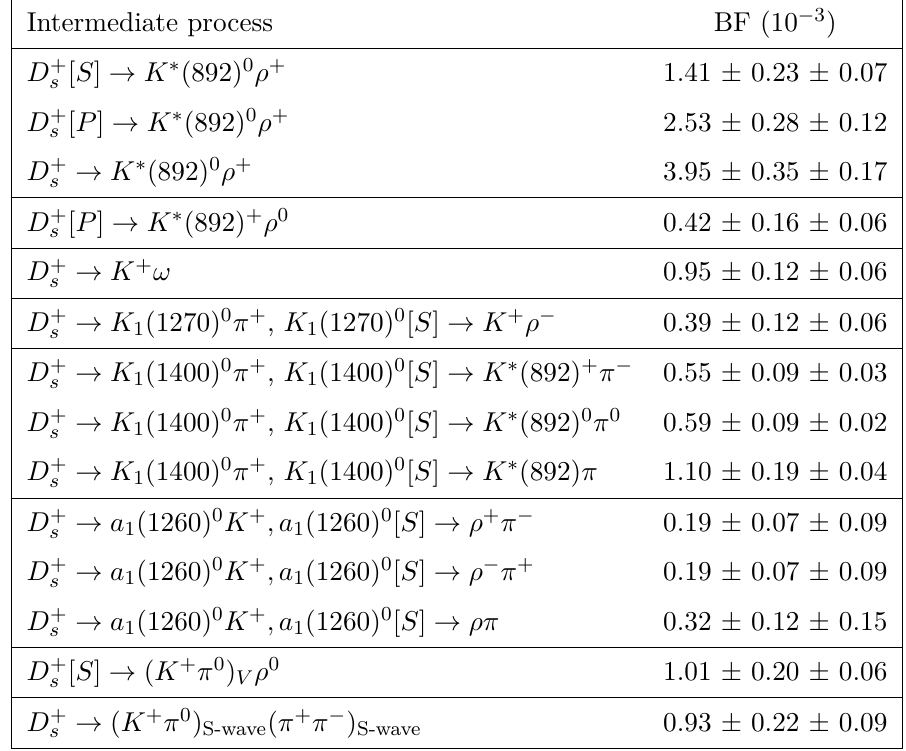
Table 12 . The BFs for various intermediate processes in the hadronic decay of D + The first and second uncertainties are statistical and systematic,